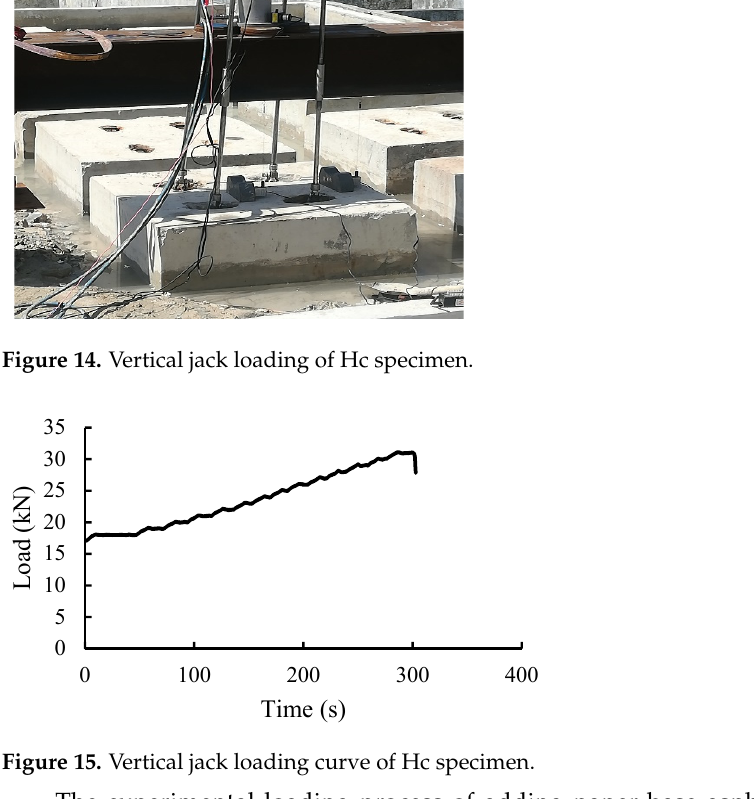
Figure 15. Vertical jack loading curve of Hc specimen. Table 5. The vertical force of the specimen with the contact surface of ordinary concrete.